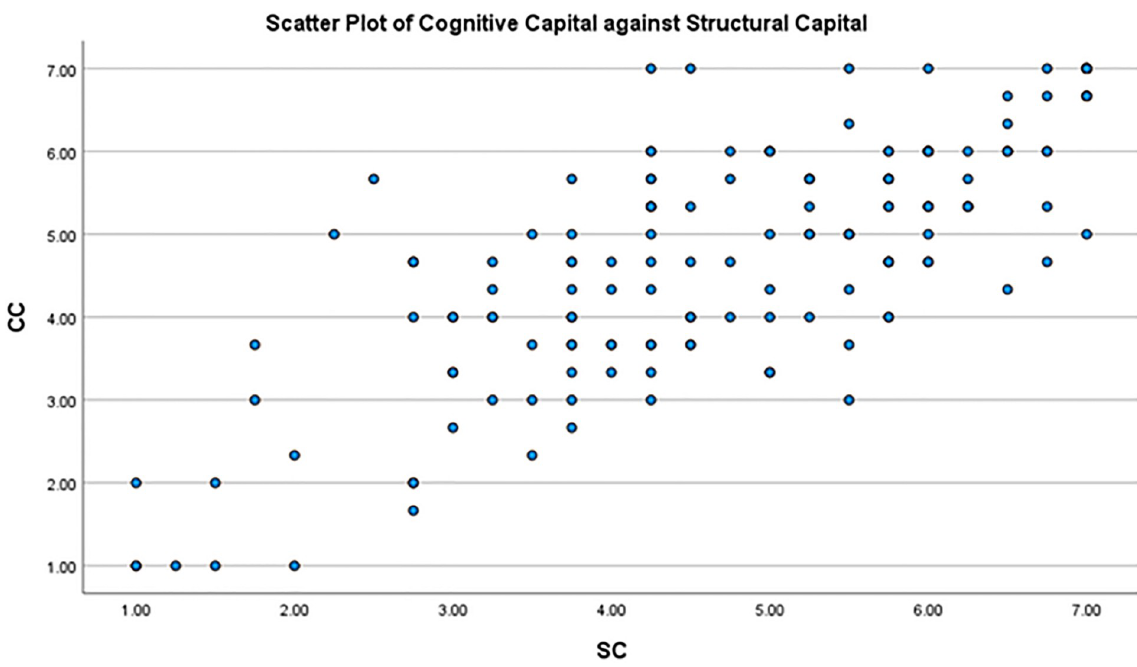
Fig 5. Scatter plot between the cognitive capital and structural capital.